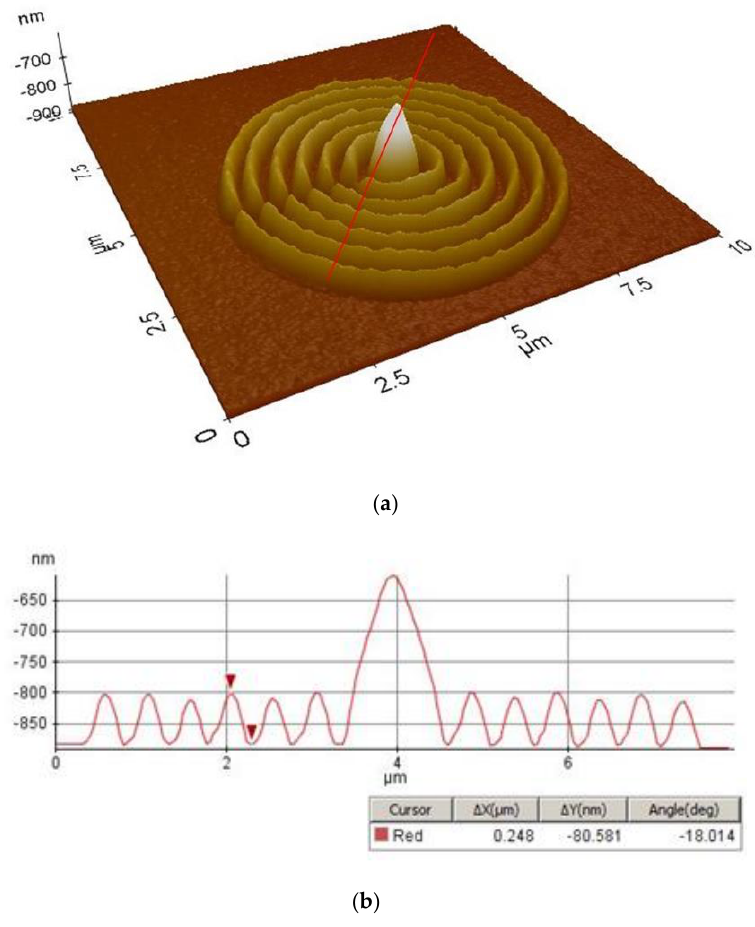
Figure 4. Detailed AFM image of the fabricated MRZ ( a ) with corresponding line profile ( b ).